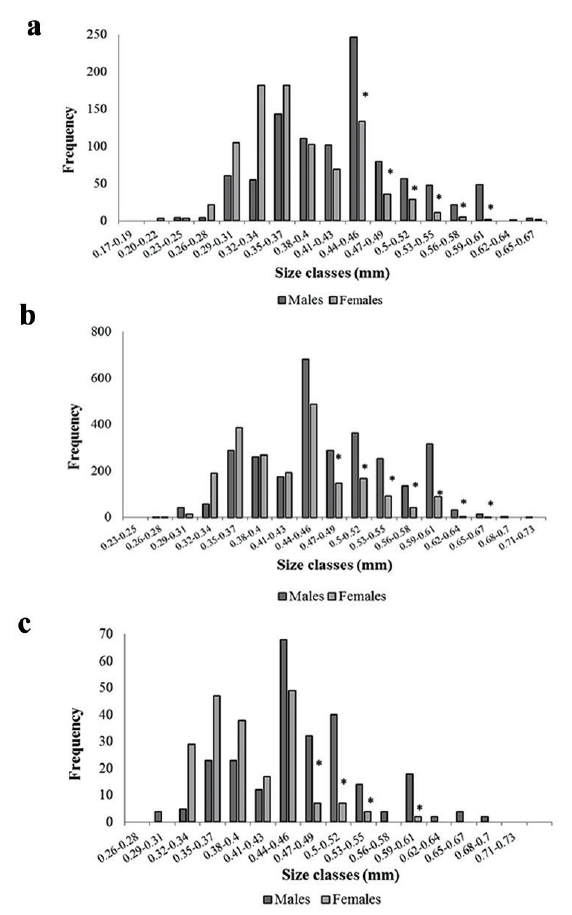
Figure 7 - Sex ratio of H. pampeana by size classes of cephalothorax length (mm) in ( a ) site 1, ( b ) site 2 and ( c ) site 3. Asterisks indicate significant differences in the proportion 1male:1female